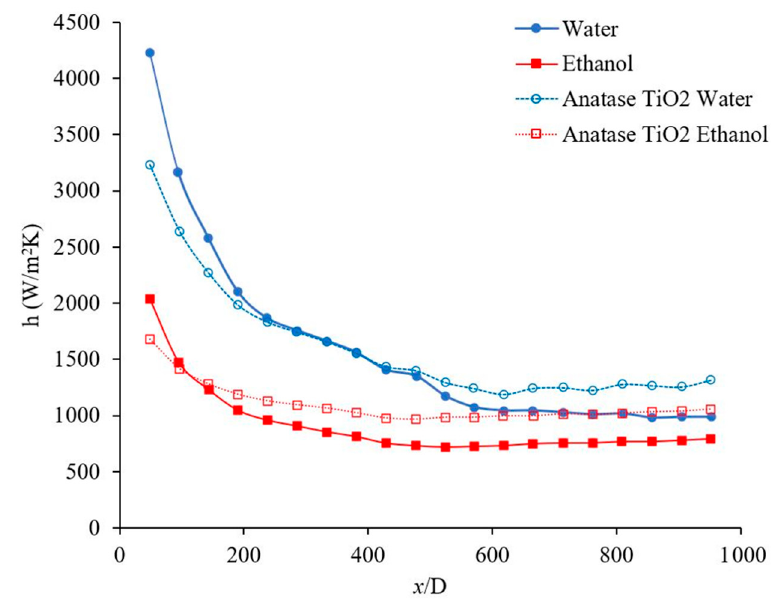
Figure 14. Variation of forced convection heat transfer coefficient as a function of distance for TiO 2 –water and TiO 2 –ethanol nanofluids. Nanofluid concentration was 1 wt %, and the range of Reynolds number inside the microchannel was 150–200. The Anatase TiO 2 nanoparticles were commercial.